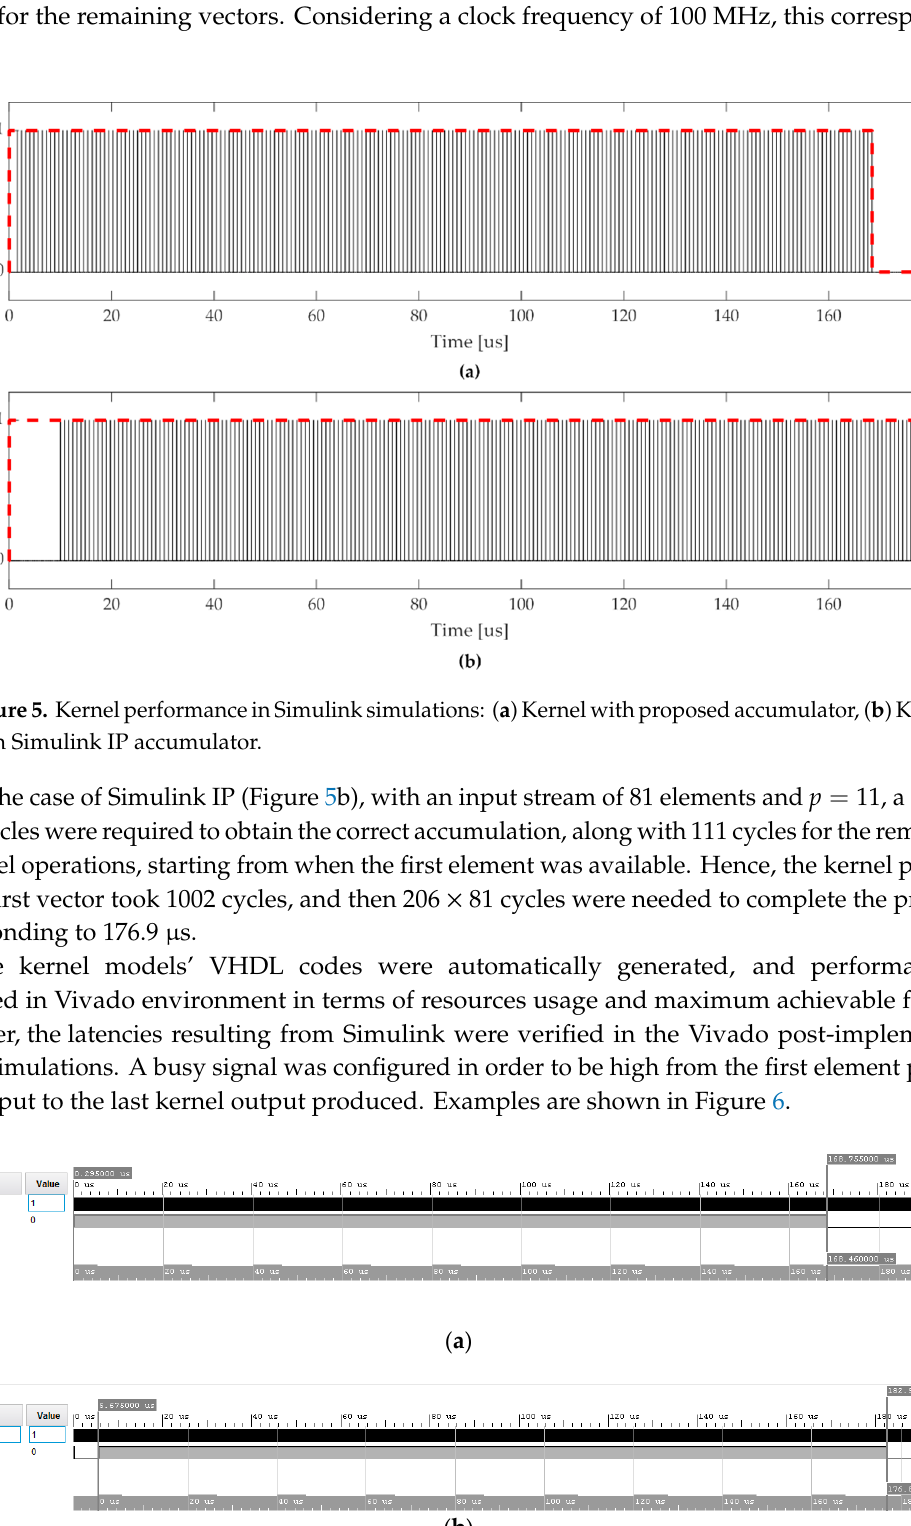
Table 5. Post implementation kernel resource usage and maximum frequency on Xilinx Artix 7 FPGA.